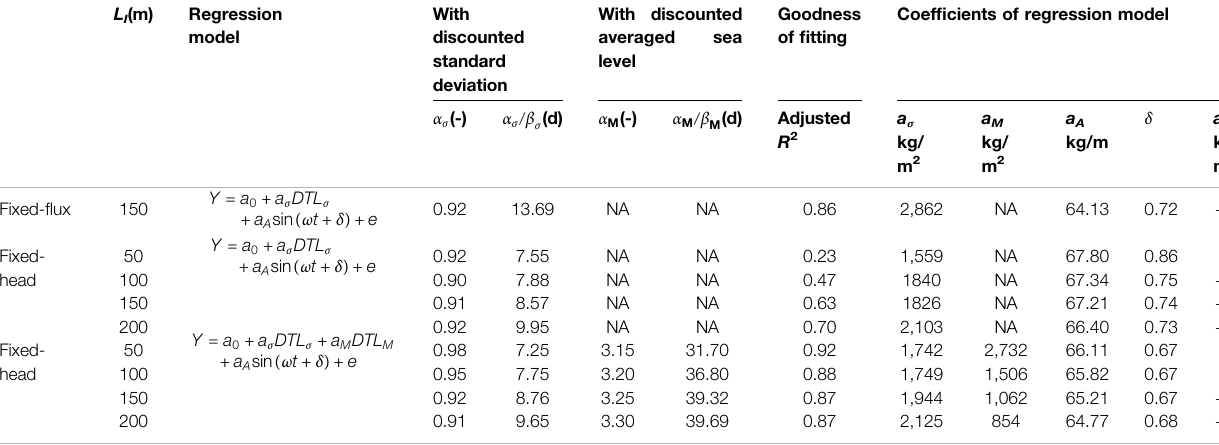
Gamma distribution function. NA means not